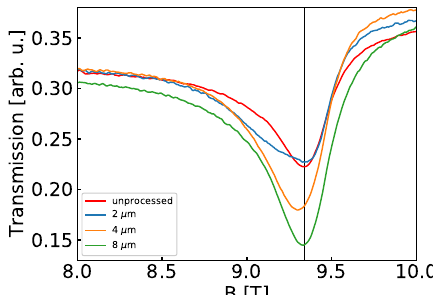
Figure 5. Transmission spectra through samples from wafer B with Au gratings of the period equal to 8 µ m, 4 µ m and 2 µ m (bottom to top) and α ≈ 0.5. A reference unprocessed sample shows the position of the CR (indicated with a vertical bar). The wavelength of radiation was 118.8 µ m.